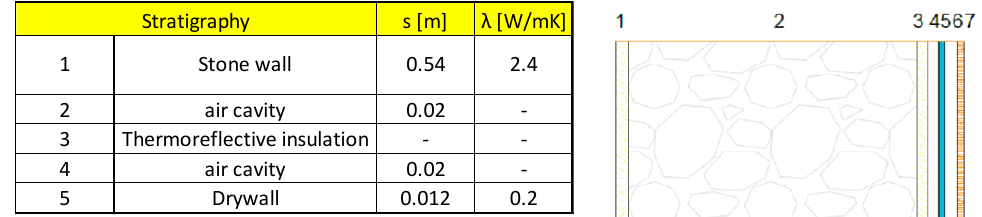
Figure A12. Wall type 4: transmittance check for the three main Italian climatic zones. In are blue the heat-reflective materials which respect all the limits.